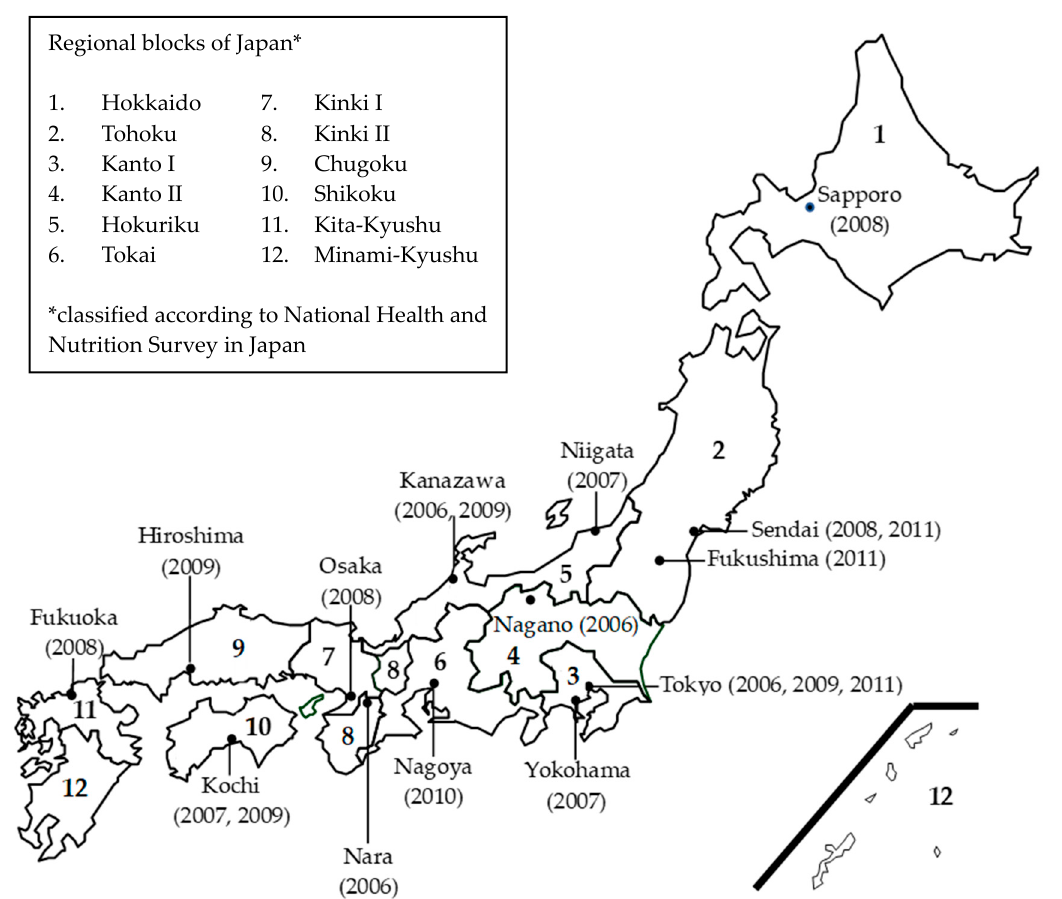
Figure 1. Sampling sites of included in the total diet study conducted from 2006 to 2011. Sampling year of each site is denoted in parenthesis.